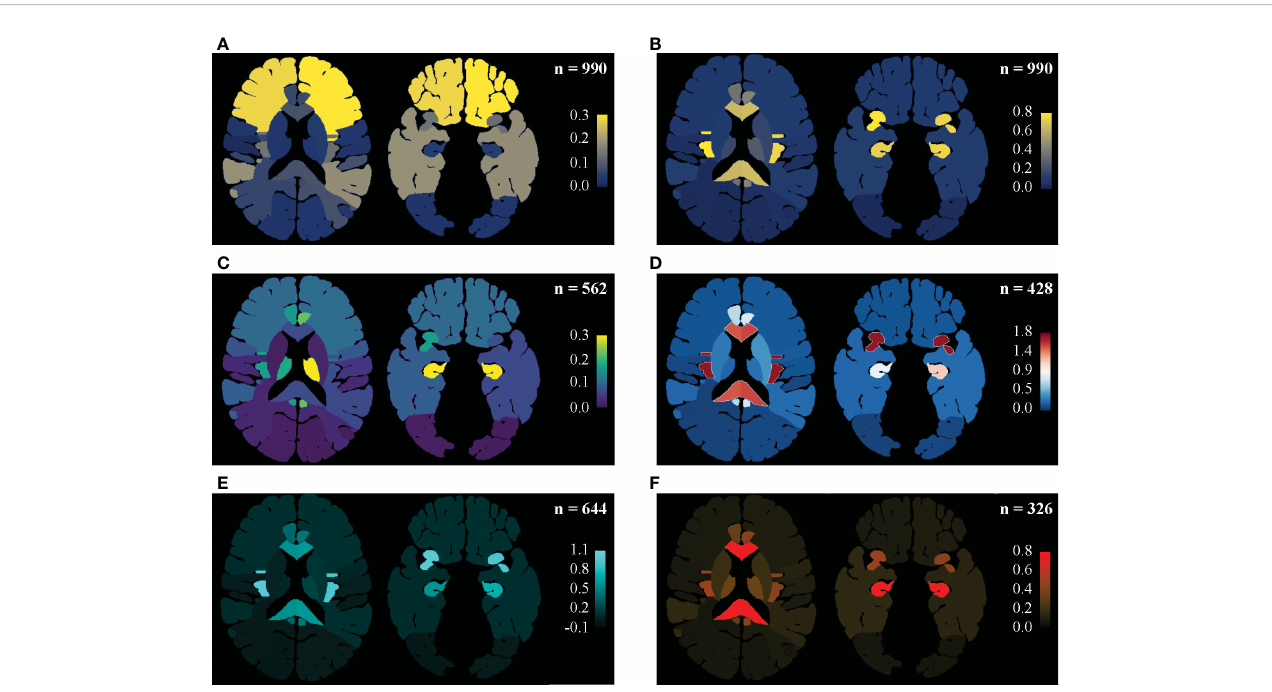
FIGURE 2 Regine-based lesion map. Distribution pattern of gliomas were illustrated as an entity and in subgroups. (A, B) In the entirety of the main set, the distributing pattern is shown in (A) , and the frequence density (per 105 mm3) are shown in (B) : the frontal and temporal lobes are vulnerable mainly for their remarkable portions of the supratentorial space, while the insulae, hippocampi, corpus callosum and gyri cinguli are real locations of predilection, isolating the effect of volume. Setting the precentral and postcentral gyri as landmarks, decreases in frequency density from the frontal to the occipital was then highlighted. (C) Frequency density mapping in sub-groups of the Localized tumors. The thalami (especially the lefr one) stood in this subgroup. (D) Frequency density mapping in sub-groups of the Multi-regional tumors. The insulae were highlighted. (E) Frequency density mapping in LGGs. Similar disproportion as in the entirety might be due to LGGs predominance. (F) Frequency density mapping in GBMs showed that the corpus callosum and hippocampi were more vulnerable to GBMs than the